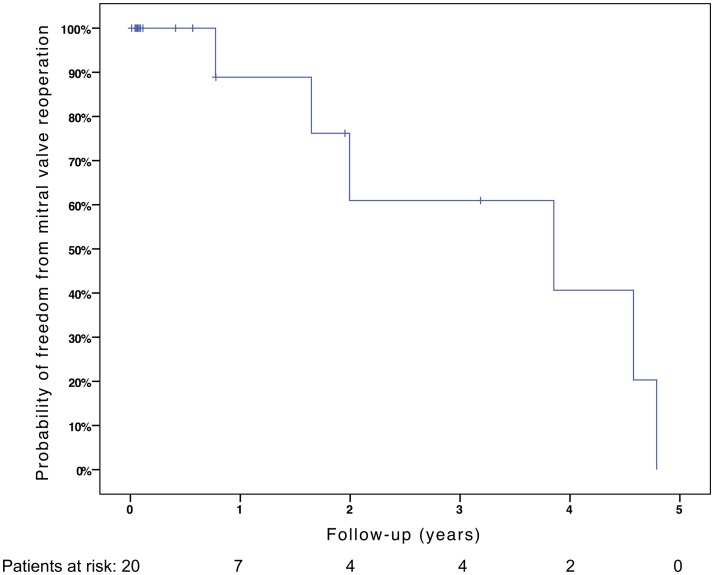
Kaplan–Meier estimate of freedom from mitral valve reoperation.